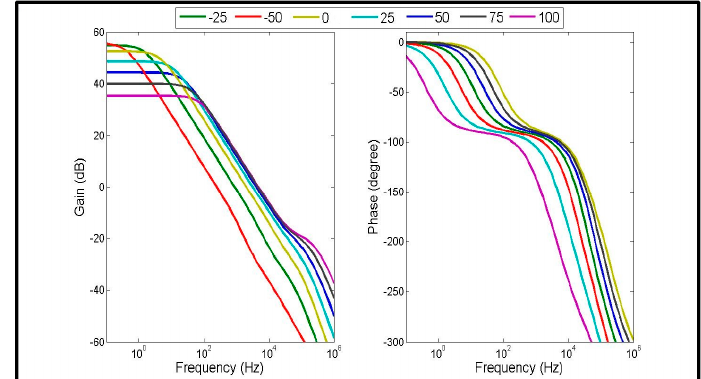
Figure 10. Temperature variation effects on the ac gain and phase response. Table 2. Effect of corners on ac response.